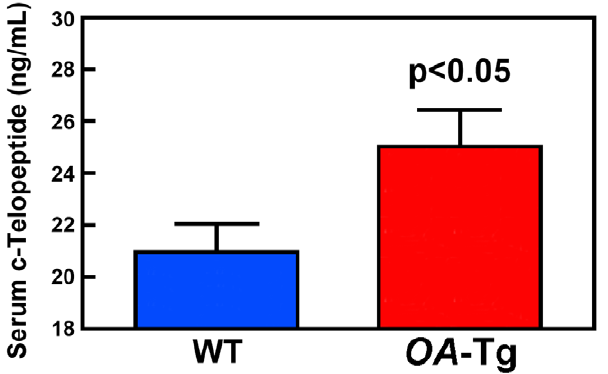
Figure 6. Targeted overexpression of OA in cells of osteoclastic lineage increased circulating levels of c-telopeptide of type I collagen. Plasma c-telopeptide levels of 8-week-old male young adult OA -Tg mice (n=17) and WT littermates (n=12) were measured with a commercial ELISA assay, and results are shown as mean 6